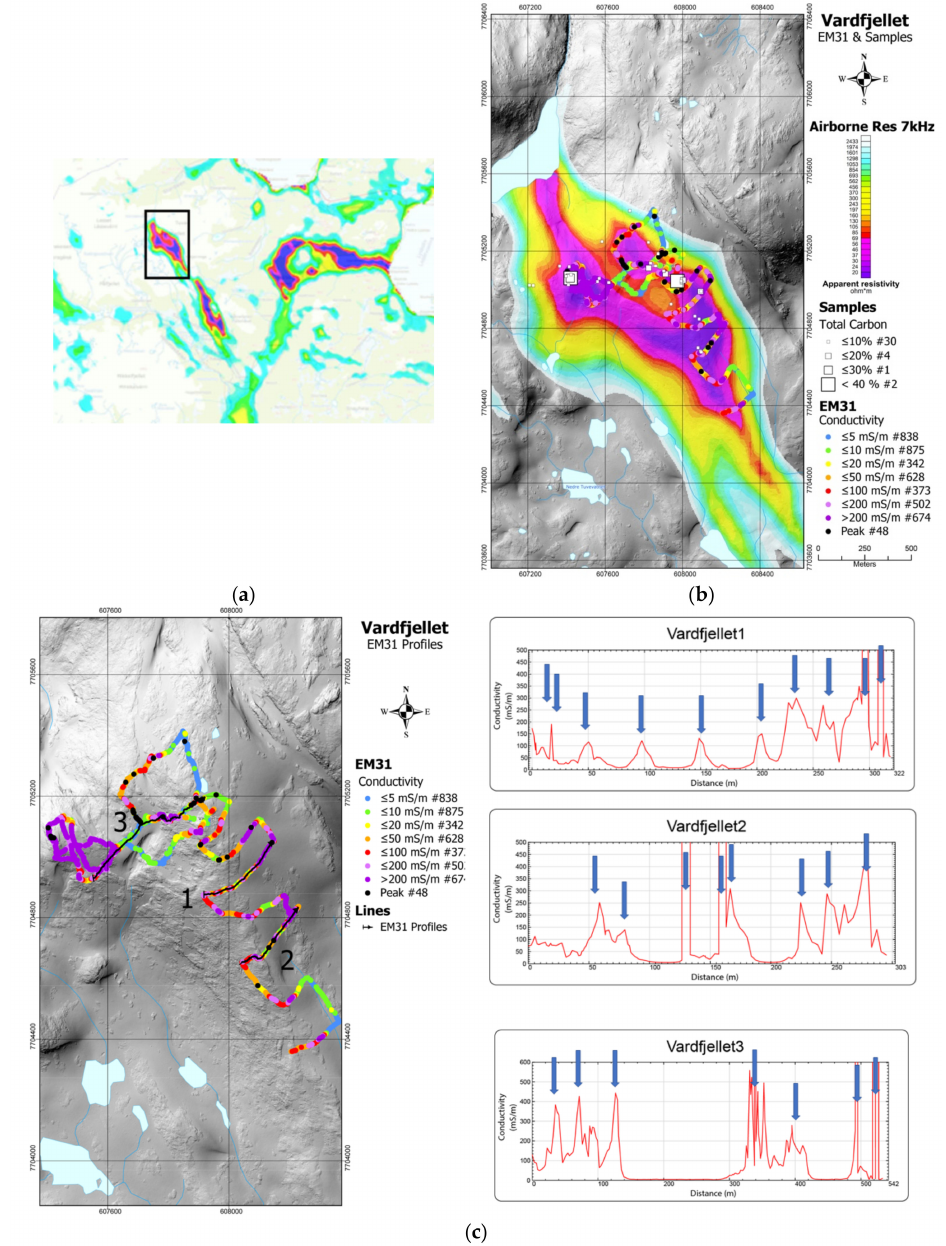
Figure 7. ( a ) Part of the airborne geophysical map showing the location of Figure ( b ). Airborne geophysical map with superimposed sampling points analysed for TC and measurements done with EM 31. ( c ) Sampling traverses of EM31 and, to the right, variation in apparent conductivity in three traverses, where peaks (blue arrows) show the location and apparent width of near-surface graphite lenses. This shows that airborne geophysics comprises several individual subparallel graphite lenses. A complexity that would not been resolved with airborne geophysics only. Data from occurrence two (Vardfjellet). Based on data from